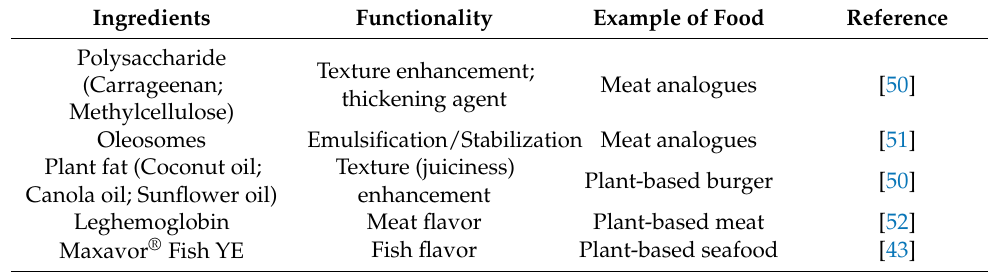
Table 4. Common ingredients used in plant-based products and